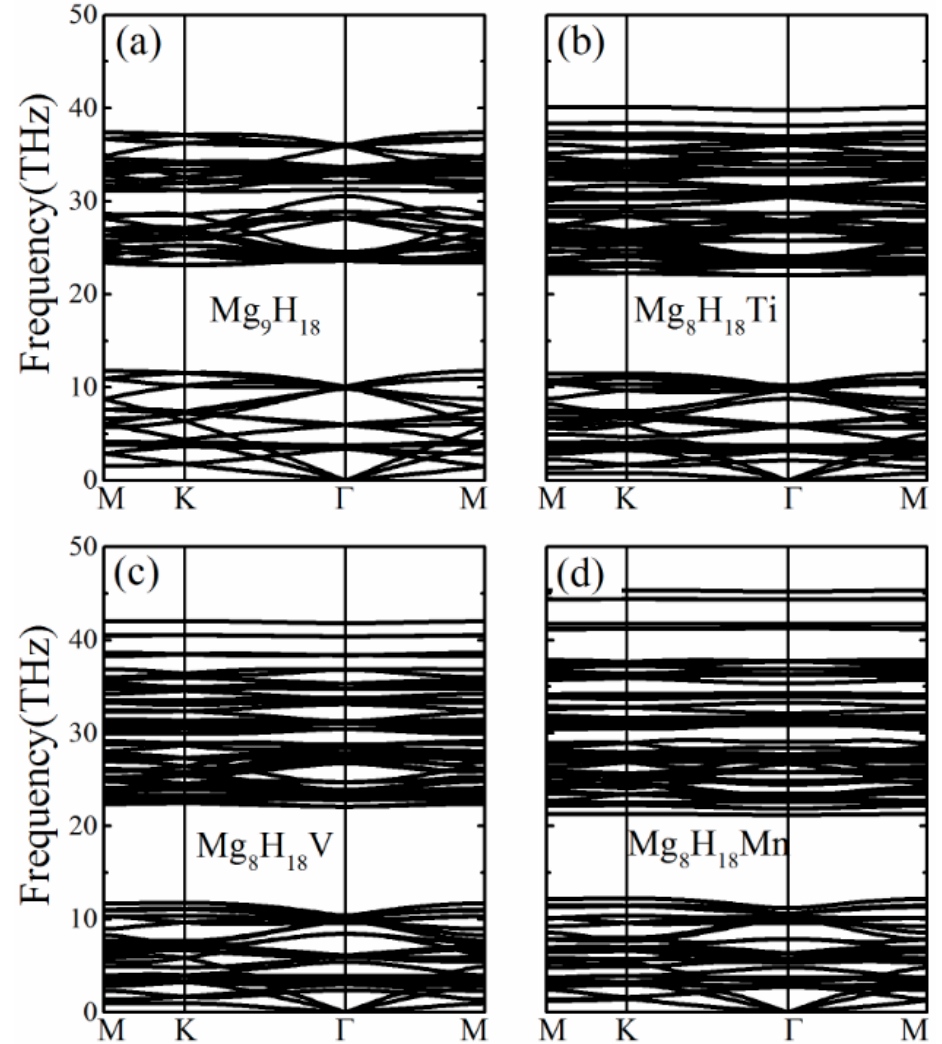
Figure 2. The phonon spectra of Mg 9 H 18 ( a ); Mg 8 H 18 Ti ( b ); Mg 8 H 18 V ( c ); and Mg 8 H 18 Mn ( d ). Table 3. The heat of formation ( Δ H ), the decomposition temperature ( T ), Bader charge of Mg and H atoms, and the dehydrogenation energies ( E d ) of Mg 9 H 18 , Mg 8 H 18, and Mg 8 H 18 X (X = Ti, V, and Mn). Δ H Hydride